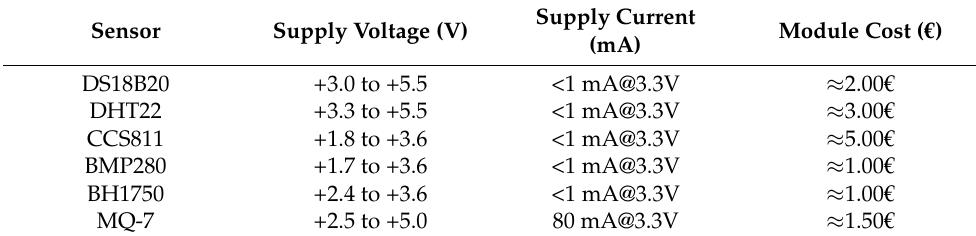
Table 9. Power Consumption and Cost of sensors in experimental